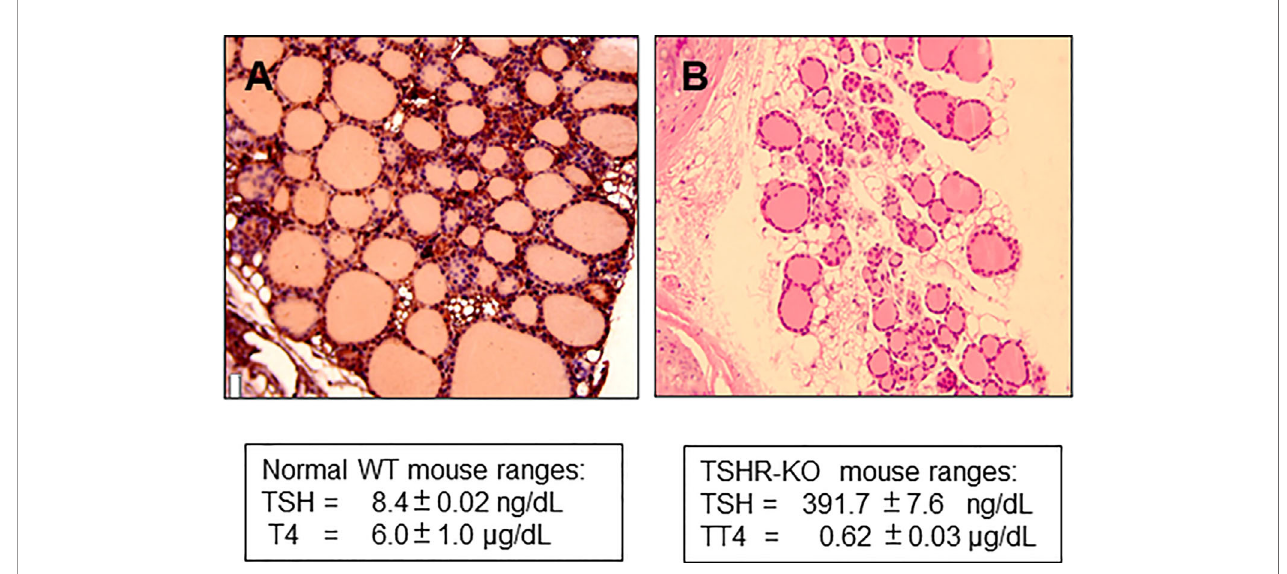
FIGURE 1 | Histology of TSHR-KO thyroid. (A) shows the histological appearance of a 6 week normal mouse thyroid gland compared to (B) taken from a 6-week- old TSHR-KO mouse. The knockout mice have approximately 1/3 of the number of follicles in a normal mouse indicating that TSH and TSHR signaling is needed for post-natal development of the